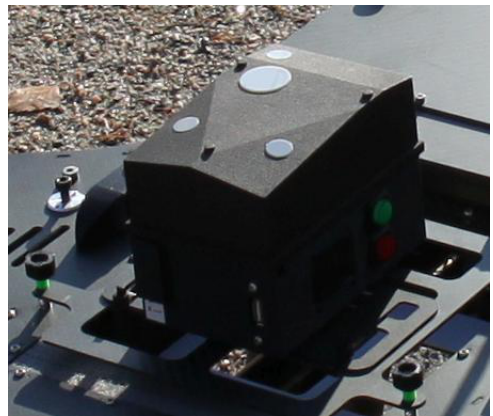
Figure 1. FGI AIRS installed on the top of the